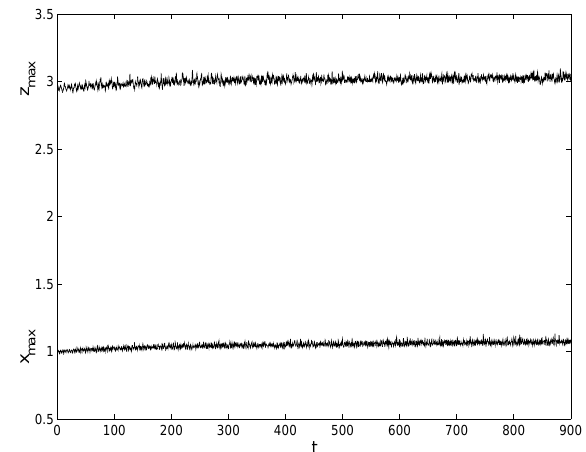
FIG. 1. Maximum (cid:120) and (cid:122) as a function of time for initially matched beam m (cid:120) (cid:173) m (cid:121) (cid:173) m (cid:122) (cid:173) (cid:49)(cid:46)(cid:48) with 6D stationary distri- bution ( (cid:99) (cid:121) (cid:97) (cid:173) (cid:51)(cid:44) h (cid:120) (cid:173) (cid:48)(cid:46)(cid:51)(cid:53)(cid:44) h (cid:122) (cid:173) (cid:48)(cid:46)(cid:50)(cid:53) ). In our recent 3D simulations [12] with the stationary distribution, no such redistribution occurred. In fact, an initially matched beam seems to be very stable, even for severe tune depressions. As an example, in Fig. 1 we plot the maximum (cid:120) and (cid:122) (scaled to the bunch radius, as described in Sec. III A) among the (cid:49) 3 (cid:49)(cid:48) (cid:54) particles in our run as a function of time for an initially matched beam, and in Fig. 2 we show the phase space diagram for (cid:99) (cid:121) (cid:97) (cid:173) (cid:51) , h (cid:120) (cid:173) (cid:48)(cid:46)(cid:51)(cid:51) , h (cid:122) (cid:173) (cid:48)(cid:46)(cid:50)(cid:53) with only 32 768 particles plotted. We now perform similar 3D particle simulations for the nonstationary Gaussian and uniform distributions.